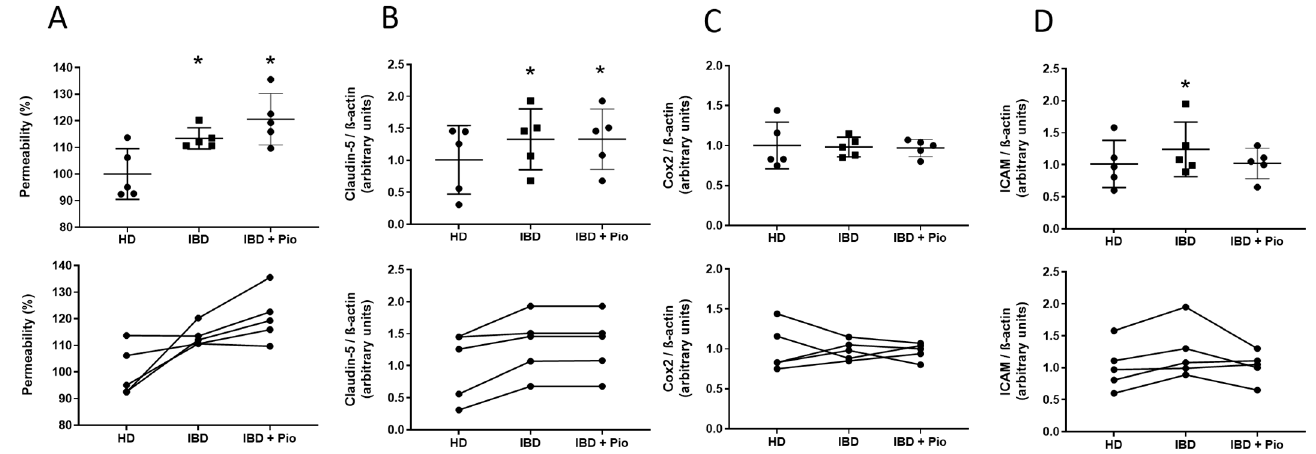
Figure 7. Effects of pioglitazone on BBB alterations induced by plasma from IBD patients. BLECs were treated with plasma from healthy donors and IBD patients at a 10% concentration for 24 h following pre-treatment with 10 µM pioglitazone for 24 h. Permeability to NaFlu through the endothelial barrier ( A ) and expression of junctional proteins claudin-5 ( B ), inflammatory protein COX-2 ( C ) and adhesion molecule ICAM-1 ( D ) by Western blotting were assessed. Results from an experiment utilizing 5 different donor pairs (n = 5) are shown as mean ± standard deviation at the upper brackets and as paired associations in the lower bracket. Data were analyzed via repeated-measures ANOVA followed by Dunn’s post hoc test. * p < 0.05 in comparison to healthy donor group. HD, healthy donor plasma; IBD, patient plasma; IBD + Pio, patient plasma plus pioglitazone added during the treatment. Permeability value of controls = 0.58 ± 0.050 × 10 − 3